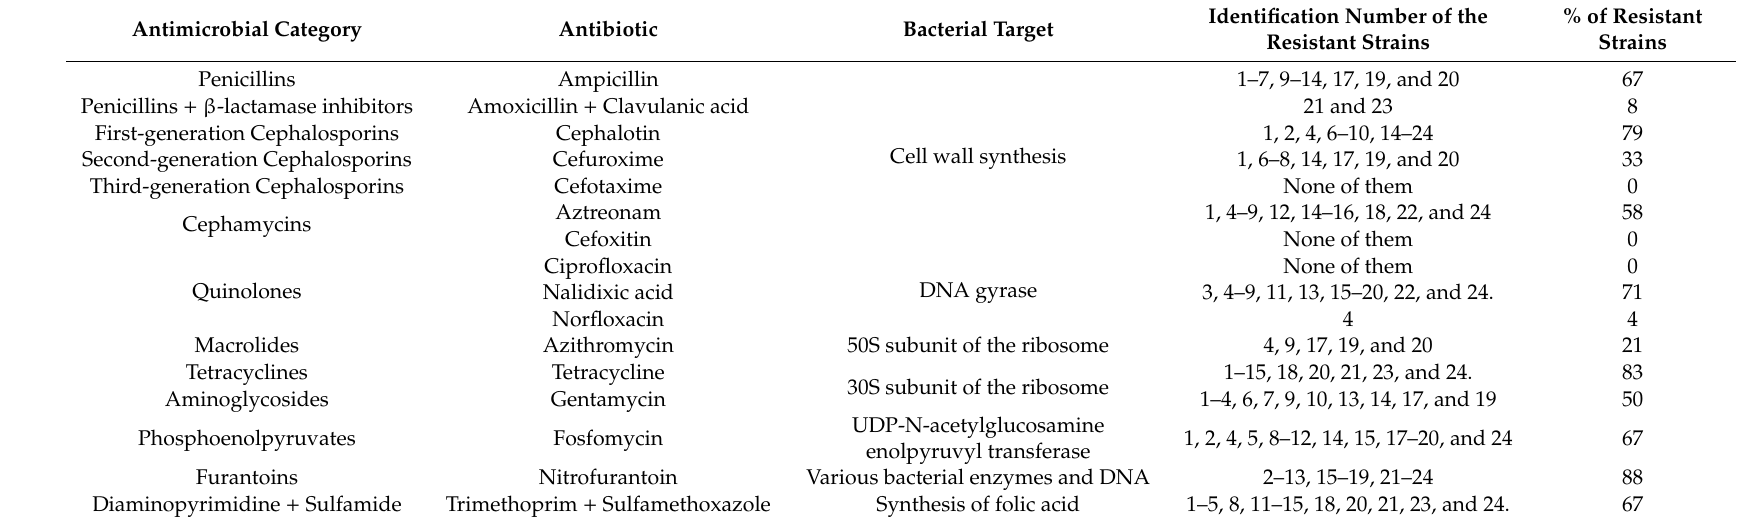
Table 1. Resistance profile of the tested clinical strains of uropathogenic Escherichia coli to various